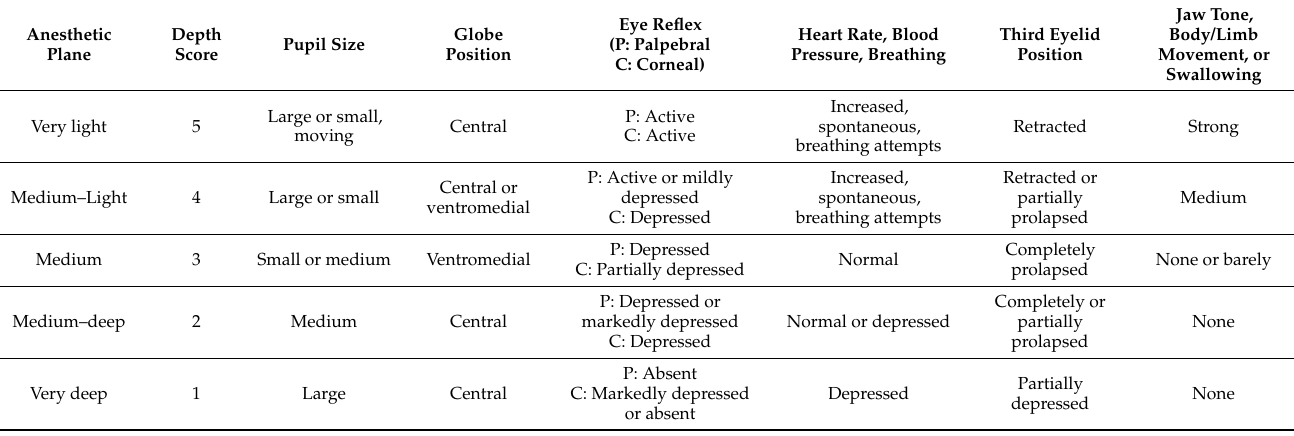
Table A1. Subjective anesthetic depth score in dogs (Modified from Raue et al., [46]). The palpebral reflex was assessed with a cotton swab and the corneal reflex was assessed with sterile saline drops on the corneal surface via